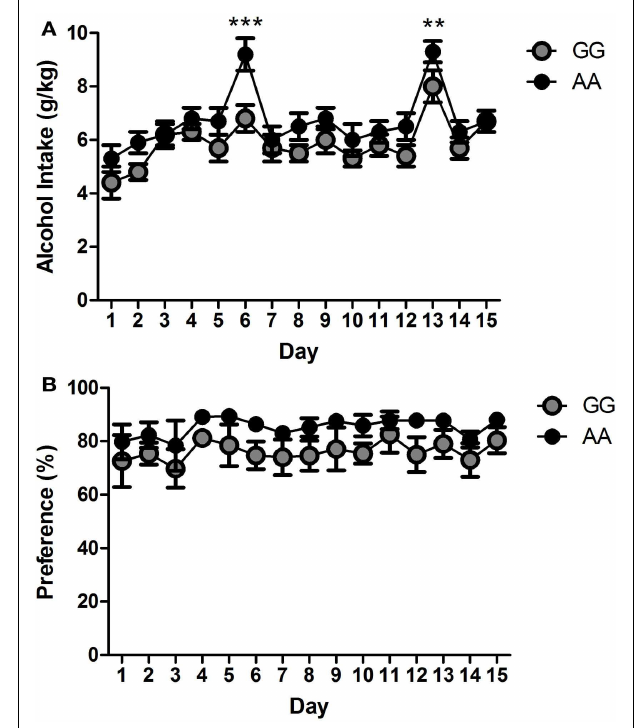
FIGURE 1 | Elevated alcohol drinking of the two msP lines GG ( n = 8) andAA ( n = 8) derived from the original msP line as assessed in the two-bottle free choice drinking paradigm. GG and AA msP rats show minimal changes in (A) drinking patterns and (B) alcohol preference across a period of 15days.Values are presented as the daily mean g/kg of alcohol intake ( ± SEM) and percent (%) of alcohol preference ( ± SEM), respectively. ** p < 0.01 and *** p < 0.001, significant difference between the two msP rat lines. GG: gray line; AA: black line. For detailed statistics, see